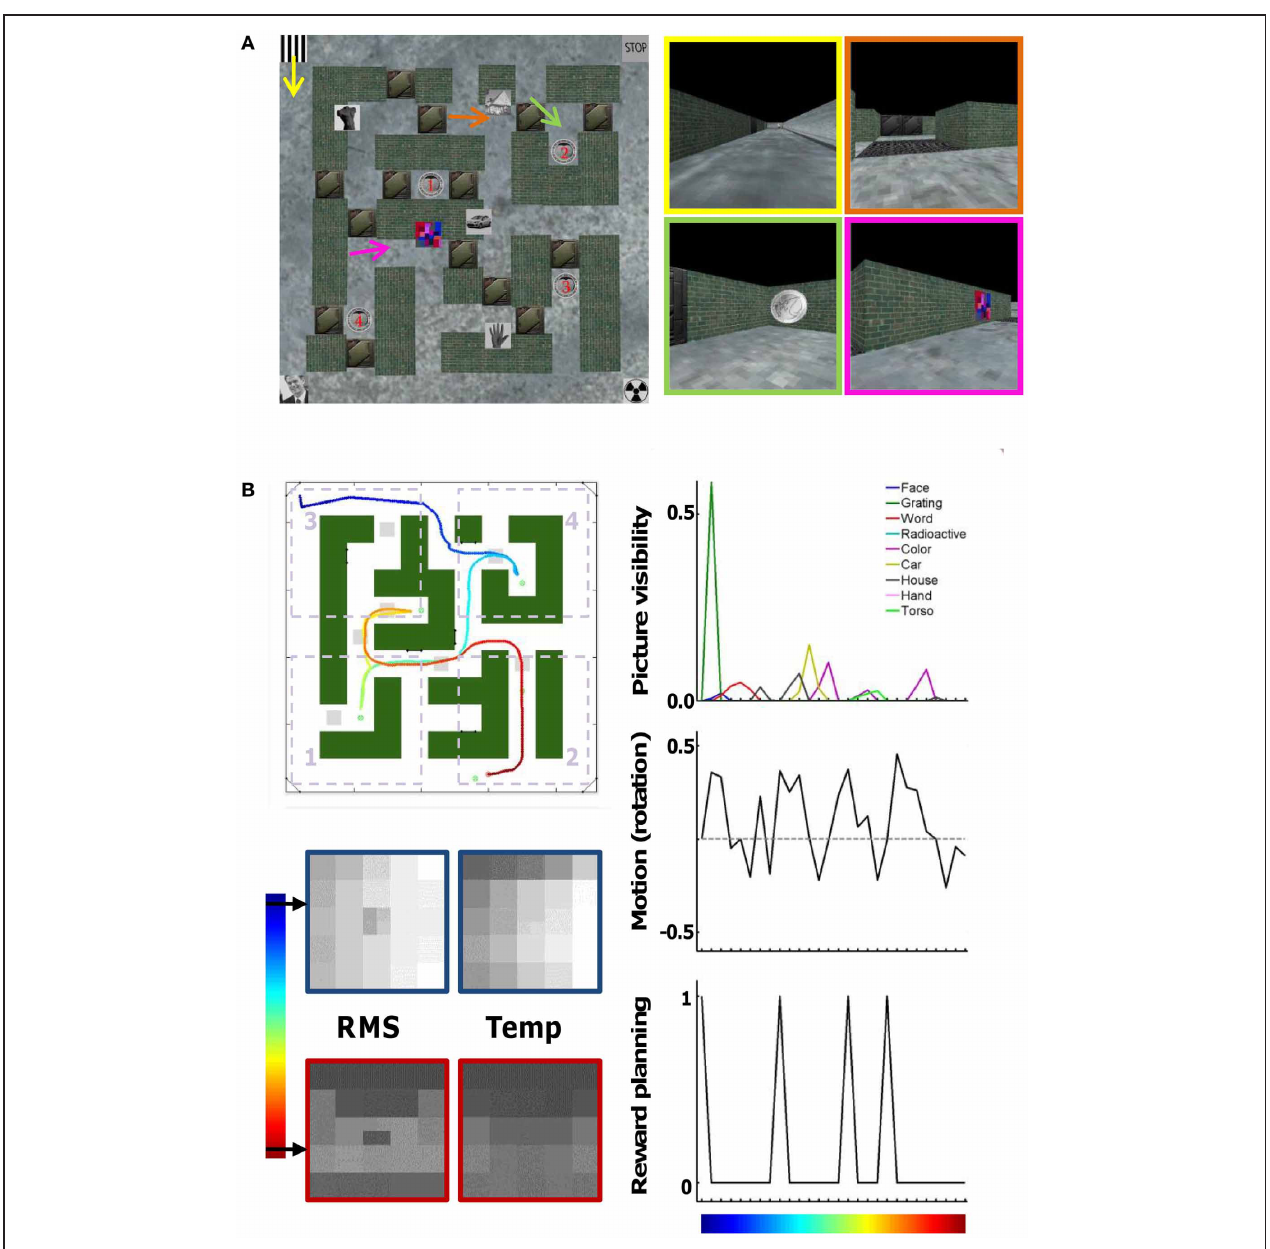
FIGURE 1 | Virtual maze environment and behavioral parameters. (A) Map of the maze with the position of brick walls, hallways, doors that could be closed or open, pictures on the wall, and rewards 1–4. On the right are a few snapshots taken at the position and viewing direction indicated by the arrows and with one possible status of the doors. For example, in the top-right screenshot the first door is open but the second door behind is closed. (B) Example route (track) taken by a subject. The map of the maze is the same, but now doors are either open (indicated by light-gray squares) or closed (shown in “green,” as are the walls). The color code of the track